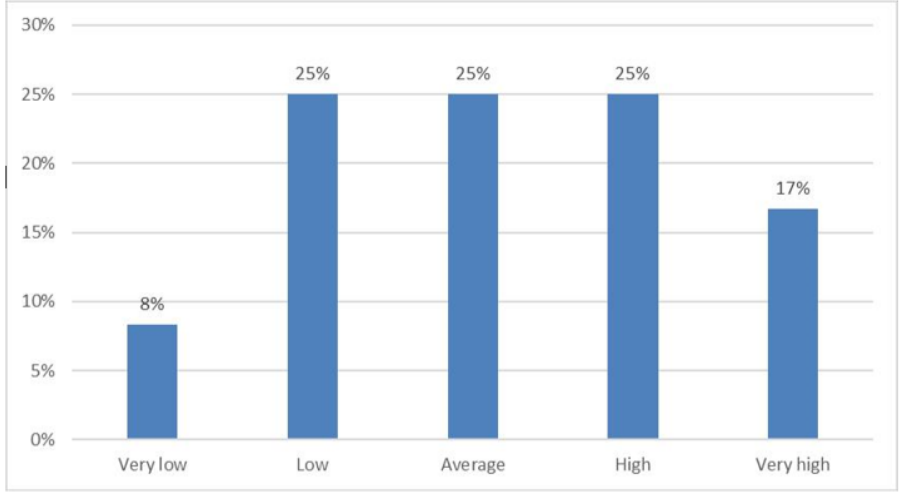
Figure 13. Fluctuations and Increases in Raw Material Prices